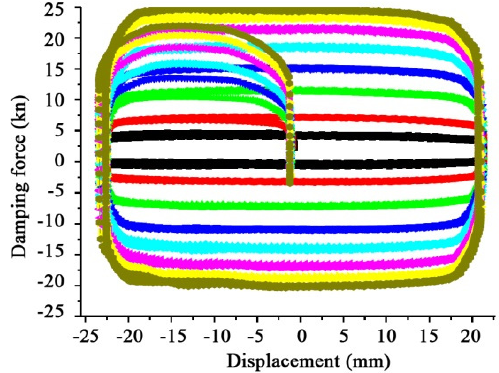
Figure 6. Damper hysteretic curve under peak value of deflection 20 mm and 0.5 ‐ Hz sine wave.